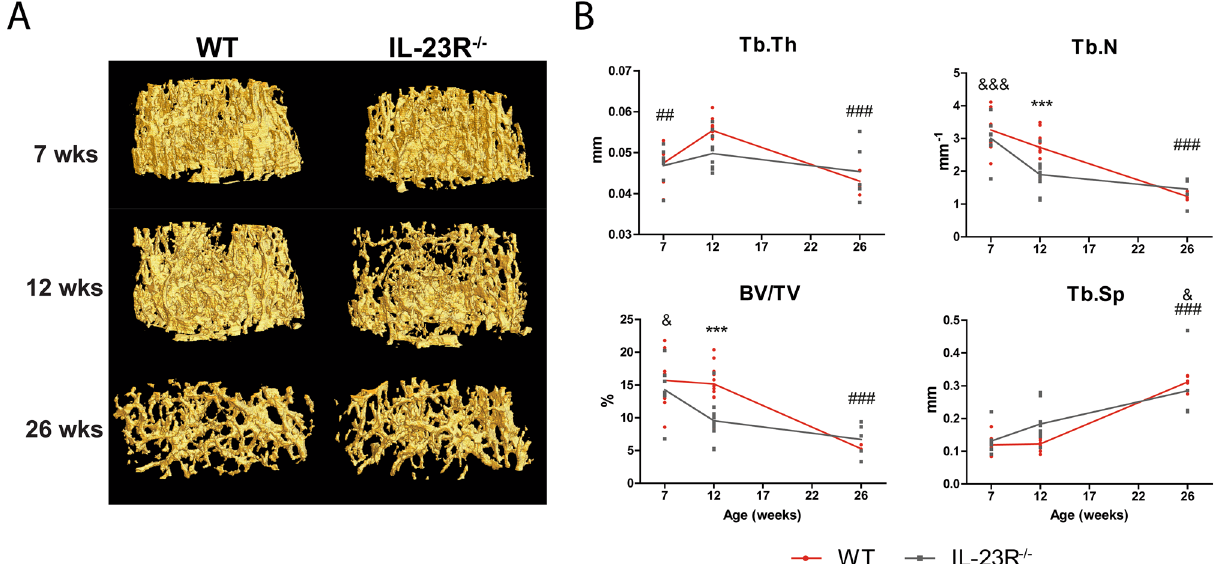
Figure 1. 12-week-old IL-23R deficient mice have lower trabecular bone mass compared to WT. Femurs of 7-, 12- and 26-week-old WT and IL-23R −/− mice were used for μCT analysis. ( A ) Representative images of µCT analysis of trabecular bone. ( B ) Trabecular bone mass parameters. Tb.Th trabecular thickness, Tb.N trabecular number, BV/TV bone volume fraction, Tb.Sp trabecular separation. Pooled data of n = 7 (7